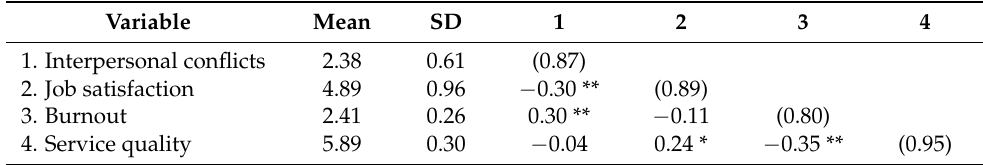
Table 1. Work unit means, standard deviations, and bivariate correlations among the main variables of the study ( n = 91 work units).